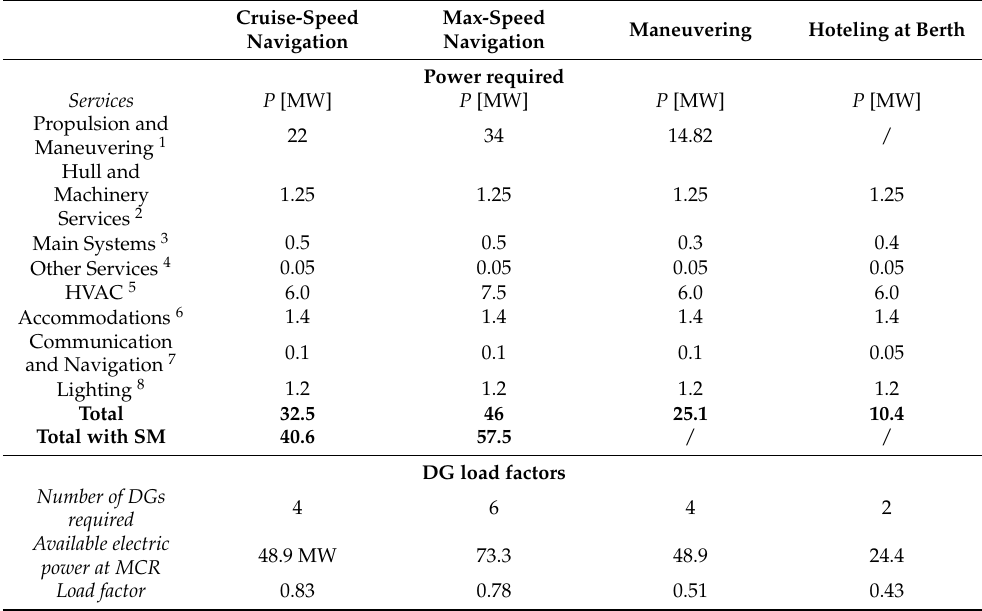
Table 4. Power required and DG load factors for the reference ship in different